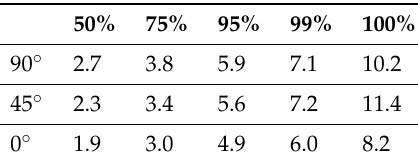
Table 6. Percentiles of σ θ ( ◦ ) for elevations 90 ◦ , 45 ◦ , and 0 ◦ .